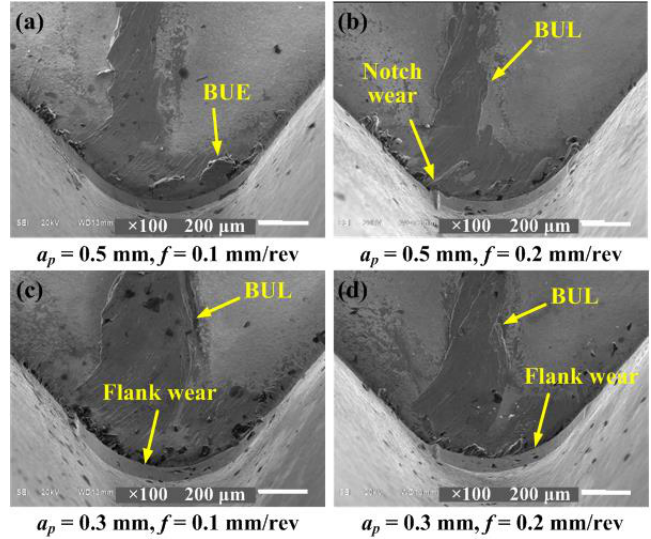
Figure 3. Tool wear patterns in face turning, ( a ) a p = 0.5 mm, f = 0.1 mm / rev; ( b ) a p = 0.5 mm, f = 0.2 mm / rev; ( c ) a p = 0.3 mm, f = 0.1 mm / rev; ( d ) a p = 0.3 mm, f = 0.2 mm / rev.